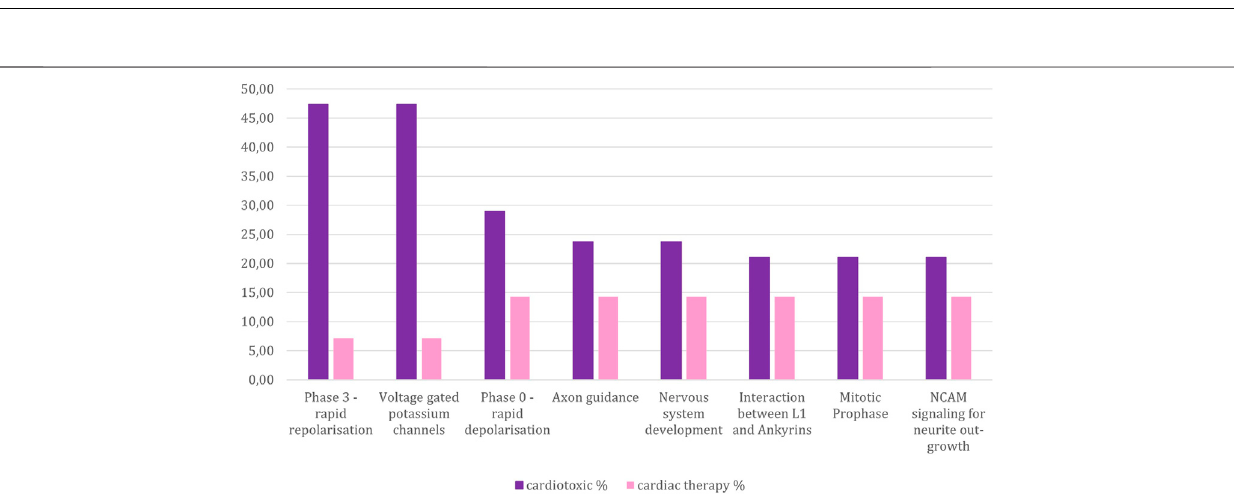
Frontiers in Pharmacology |